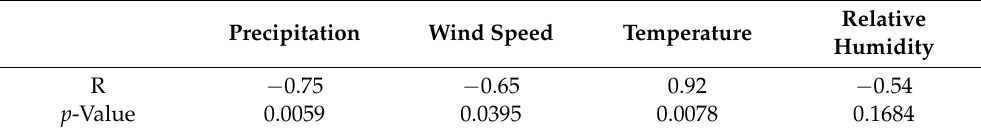
Table 5. Pearson correlation coefficient (R) and p -value between number of trips and climate parameters.